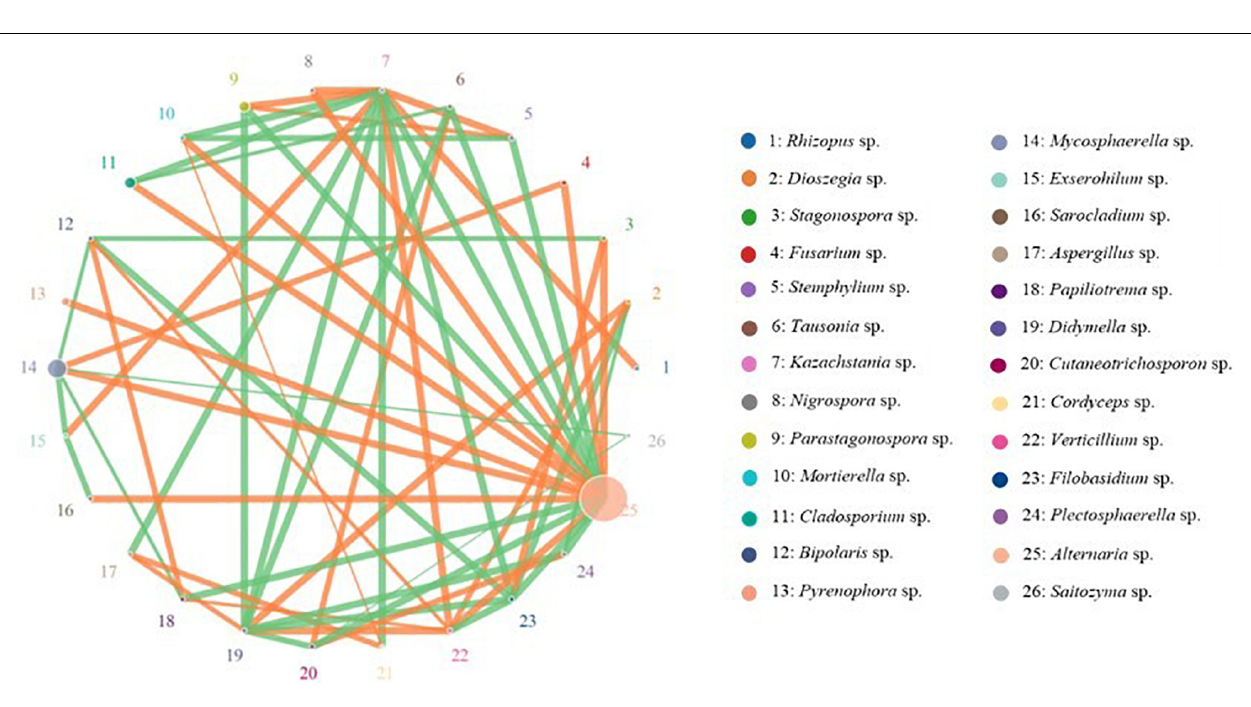
FIGURE 8 | Network analysis on the fungal communities in different oat seed samples. Node represents species and its size represents abundance. The line represents correlation between two species, line thickness represents strength of correlation. The orange line represents a positive correlation, whereas the green line represents a negative